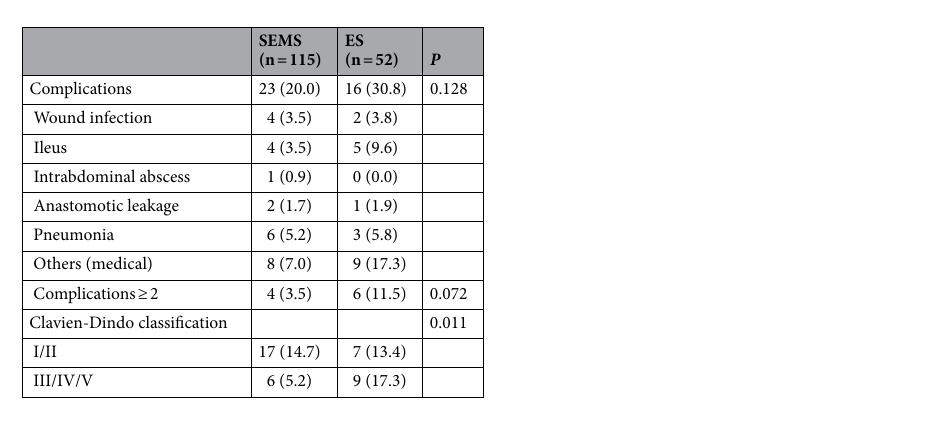
Table 3. Postoperative complications in obstructive colorectal cancer. Data are presented as the number of patients (%) or median (standard deviation) unless otherwise stated. SEMS self-expandable metallic stent, ES emergent surgery , n